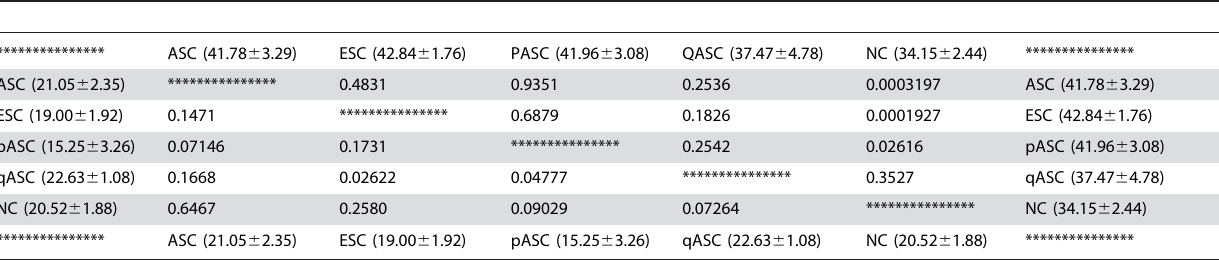
Table 11. The distribution of the promoter usage in the different SC types and the negative controls (NCs); the upper right section of table considers CpG-richness, whilst the lower left section considers the AP